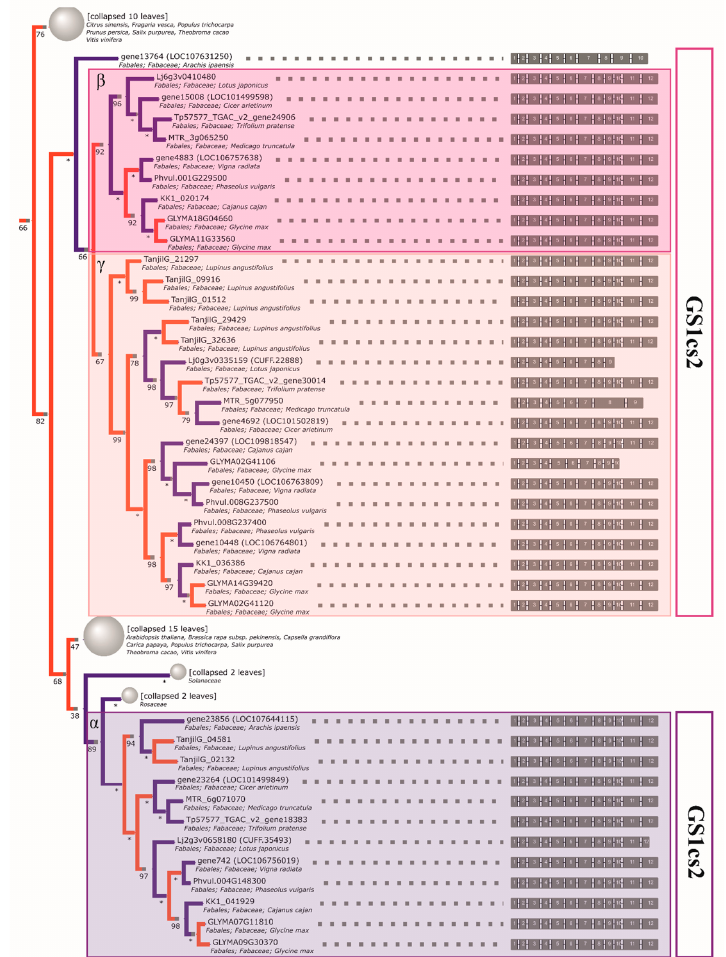
Figure 2. The reconstructed phylogeny of plant cytosolic GS isoenzyme ( GS1 ) genes. A collapsed phylogeny tree was used in order to highlight Fabaceae family relationships. Both one PEPC2 (PTPC, plant-type PEPC [50]) clade and two PEPC1 (BTPC, bacterial-type PEPC) clades can be clearly characterized as monophyletic in legumes. Therefore, three ancestral